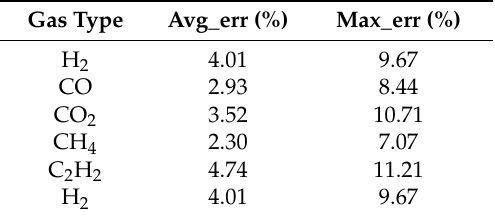
Table 1. Other gases concentration prediction error (%).